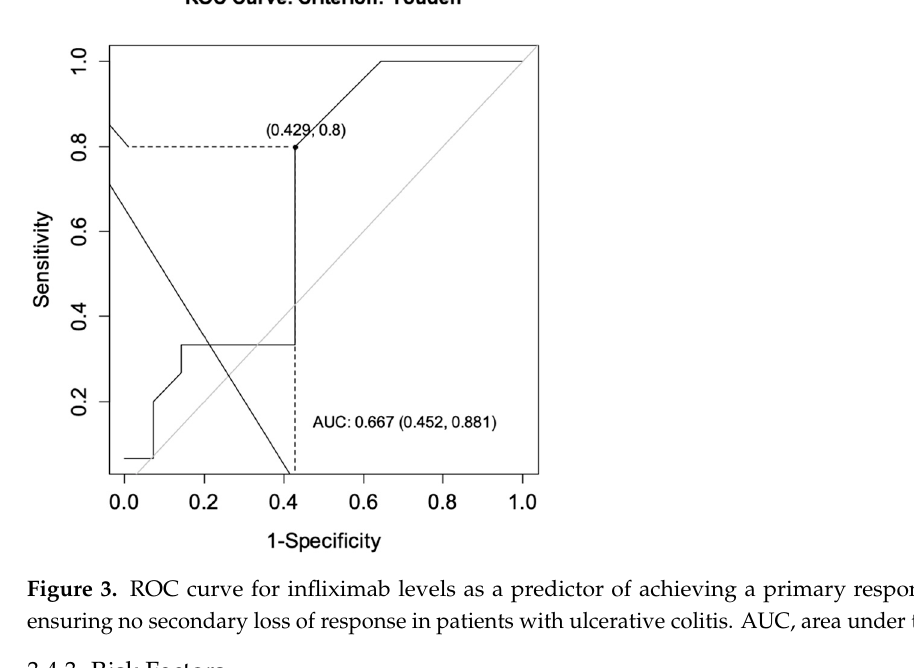
Figure 2. ROC curve for infliximab levels as a predictor of achieving a primary response while en- suring no secondary loss of response in patients with Crohn’s disease. AUC, area under the curve.